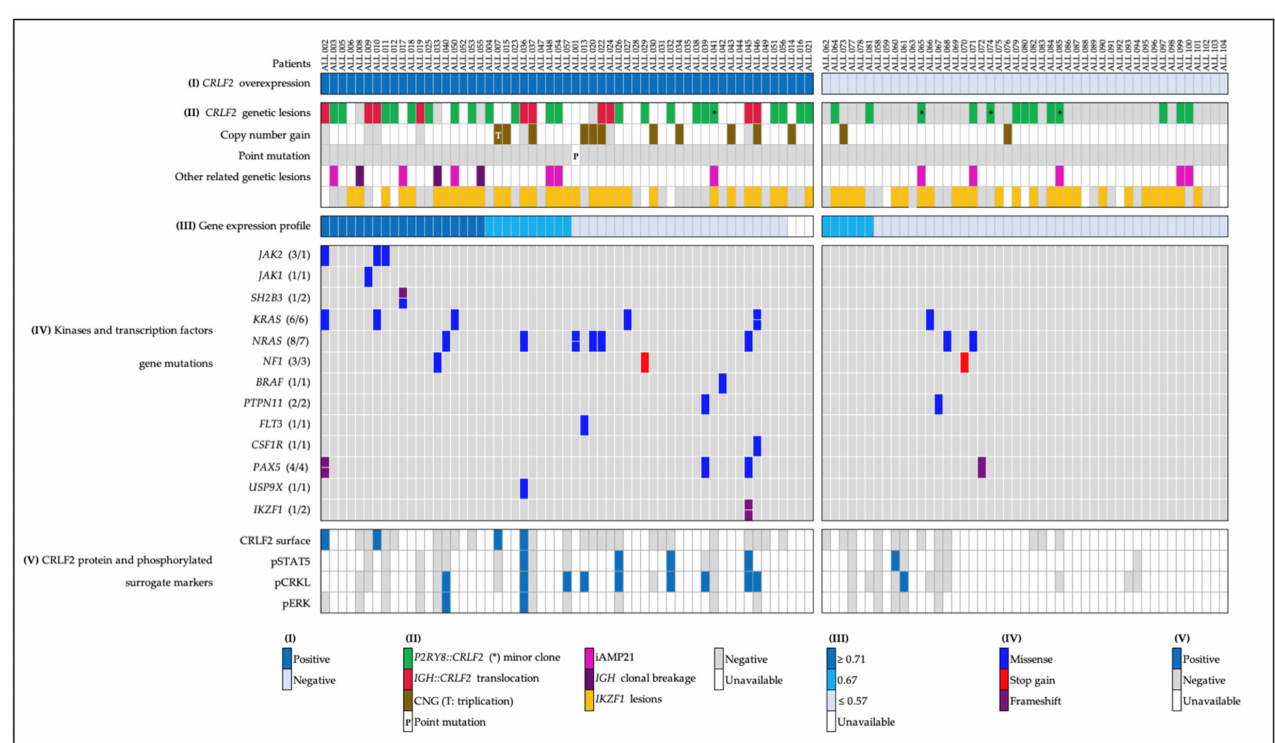
Figure 1. Genetic landscape of pre-B ALL cases clustered according to the CRLF2 expression. Each column represents a patient, and the rows represent genetic or biochemical features. Gene mutations are shown in parenthesis as follows: patients harboring the mutation/different mutations identified. CNG: copy number